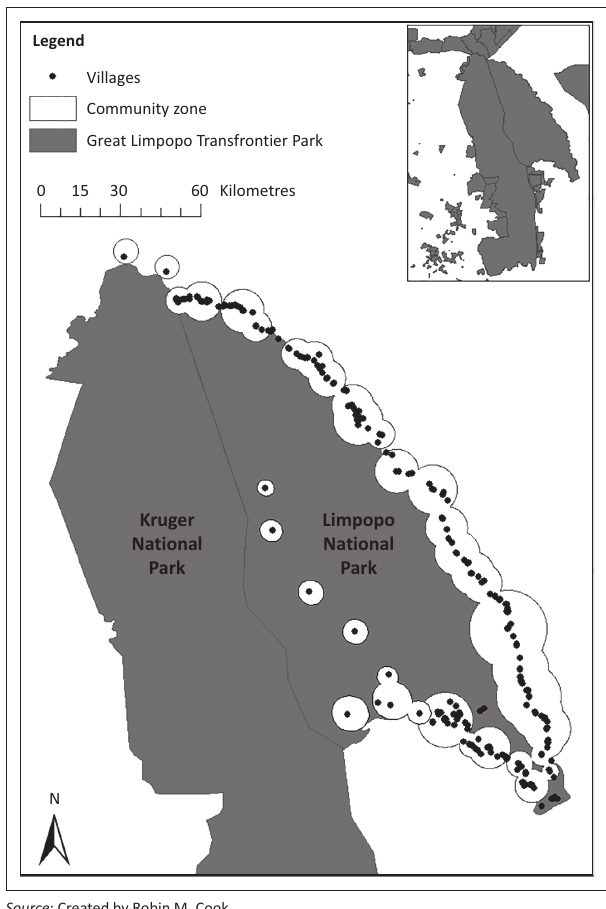
FIGURE 1: Location of villages and community zones within Mozambique’s Limpopo National Park and along the Limpopo River of South Africa’s Kruger National